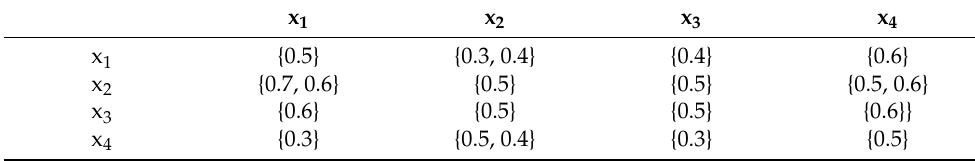
Table 1. The HFPR given by expert e 1 .